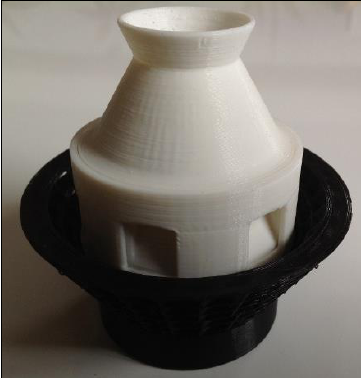
Figure 12. A nozzle block prototype (shown on the left) and a control sleeve (diaphragm) prototype in the closed position.